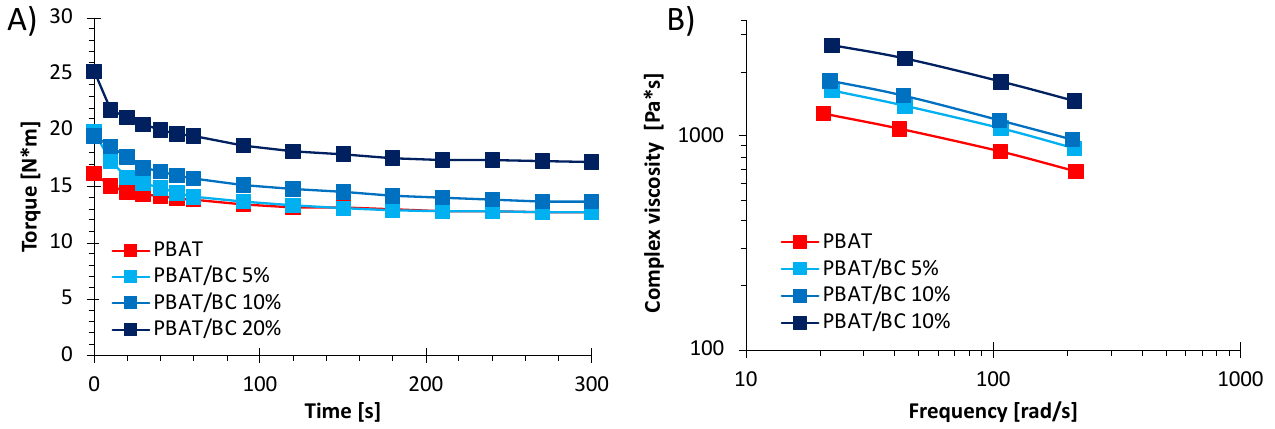
Figure 1. ( A ) Torque as a function of time and ( B ) complex viscosity as a function of the frequency of PBAT and PBAT/BC biocomposites.